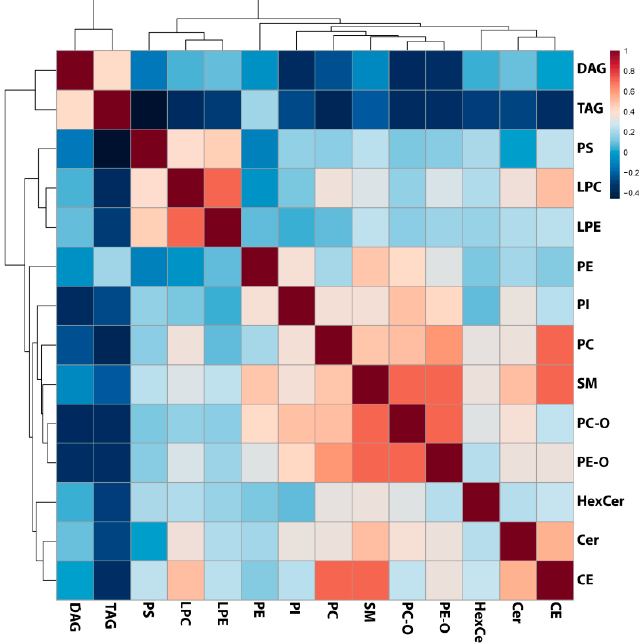
Figure 3. Results of the Pearson’s correlation analysis performed for all identified lipid classes and presented as a heat map with the corresponding hierarchical tree. Color saturation corresponds to the value of Pearson’s correlation coefficient.